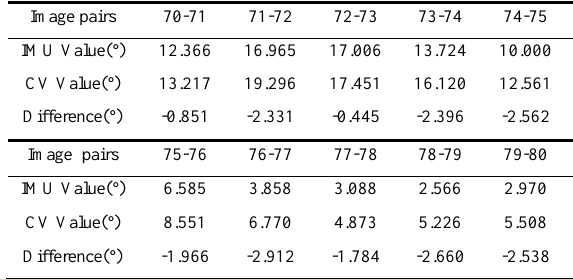
Table.2 The heading angle of IMU measurement and CV Calculation